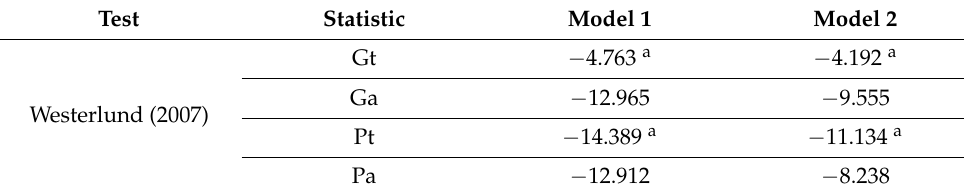
Table 6. Tests of